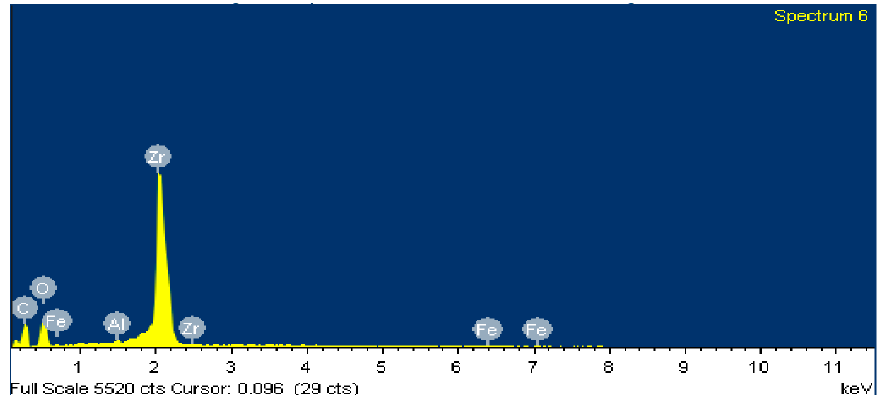
Figure 14. EDS spectrum for zone 1 in the PA46Z sample.